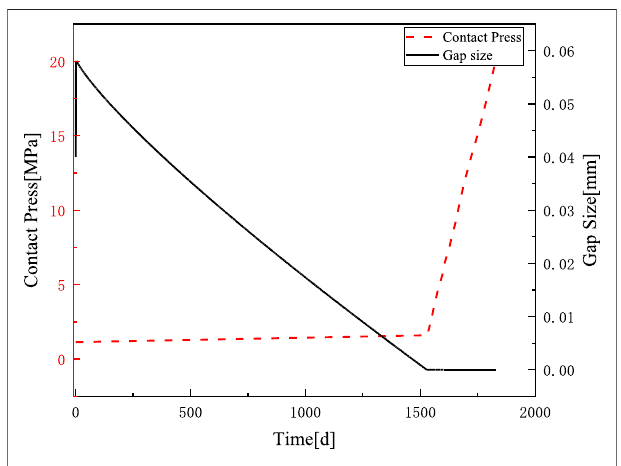
FIGURE 12 | The change of contact press and gap size versus time.